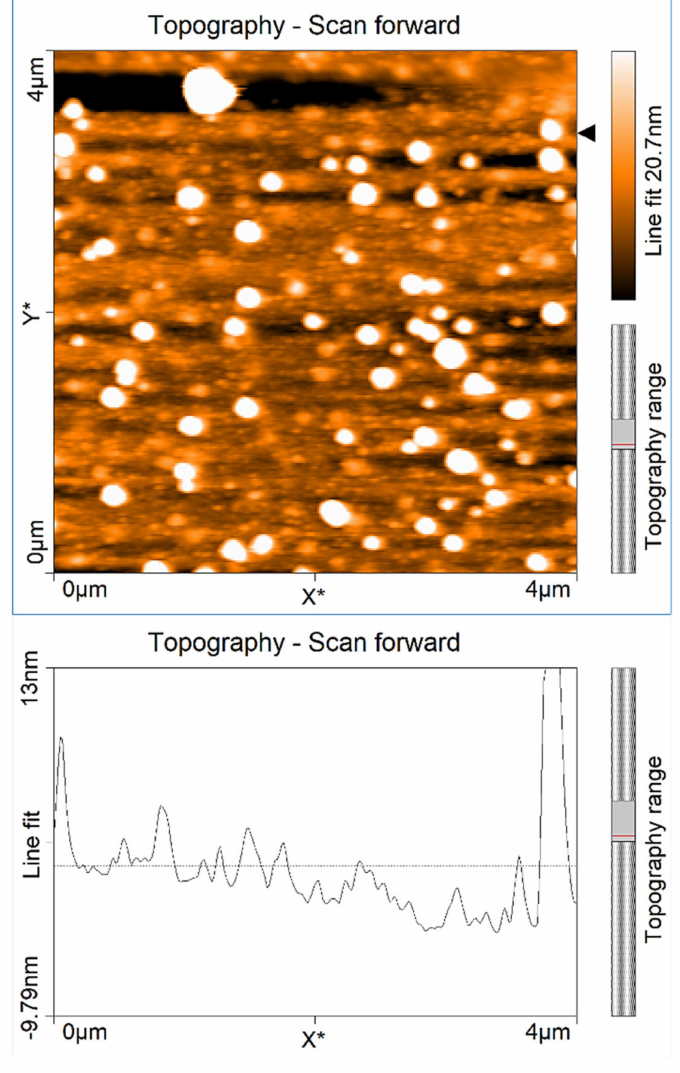
Figure 4. AFM image of GaN sample grown under gallium-rich conditions with 45 pulse cycles (as mentioned in the text). RMS surface roughness of 9.3